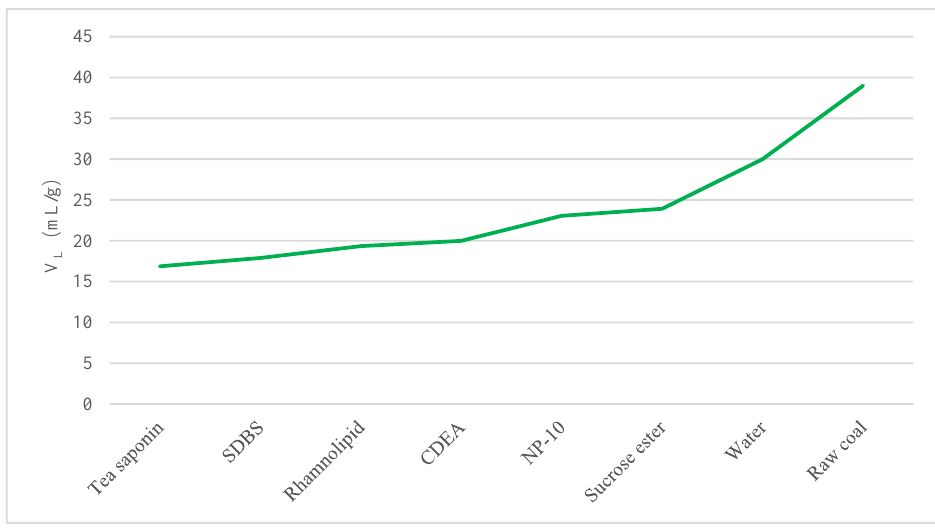
Figure 8. Coal desorption capacity after using surfactants from the perspective of NMR (the lower V L value, the better coal desorption capacity).